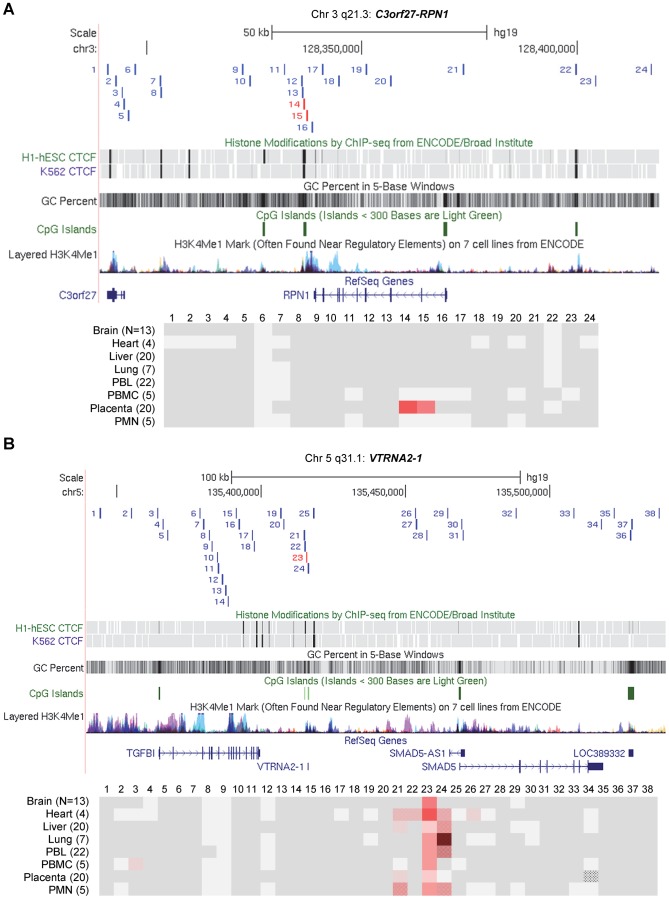
Long-range methylation mapping of the two imprinted regions, C3orf27-RPN1 and VTRNA2-1, in 8 types of human tissues, shows small discrete DMRs.Maps from the UCSC genome browser (top) and ASM heat maps (bottom) derived from long read bis-seq in the gene regions. In the genome browser map, the index amplicons that provided the starting points for the mapping are in red, and CTCF binding sites, GC percentage, CGIs and H3K4me1 activating mark intensities are shown. In the heat maps, light grey shading indicates homozygosity in all samples, and dark grey indicates heterozygosity in one or more sample with no evidence of ASM. Shades of red indicate ASM, with the intensity scale indicating the absolute value of the difference in fractional methylation of the two alleles from 0.30 to 1. These data are averaged over all heterozygous samples for a given tissue. The red stippled cells indicate tissues with a greater than 0.30 average difference in fractional methylation of the two alleles but with only one heterozygous sample or with less than half of the samples showing significant ASM (p≤0.05, using the t-test). The grey stippled cell indicates an amplicon with insufficient read depth (<10). The number of samples subjected to bis-seq for each tissue is indicated in the parentheses. A, The C3orf27-RPN1 region shows a single discrete epicenter of ASM (DMR) which overlaps with the initial index fragment discovered using MSNP data. ASM in this domain is only present in placenta. B, The VTRNA2-1 region shows a single discrete epicenter of ASM (DMR) which overlaps with the initial index fragment discovered using MSNP data. ASM in this domain is present in all 8 tissues. However, ASM with less robust evidence and less consistency between samples (stippled red cells) was found in several immediate flanking amplicons (amplicons 21, 22, 24, 26).